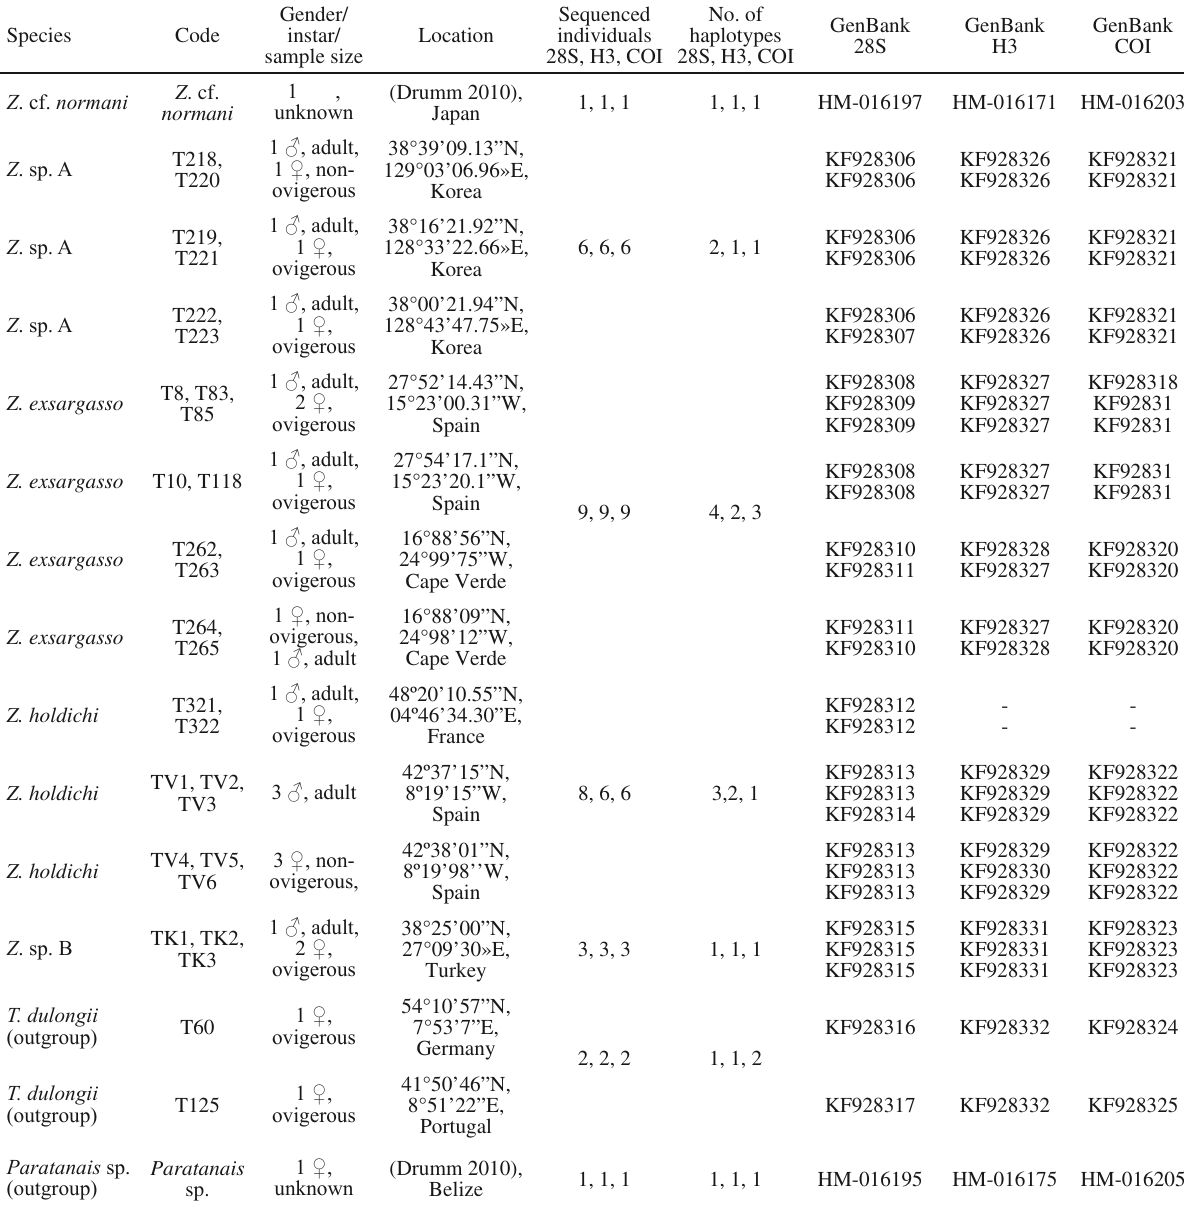
Table 1. – Details of Zeuxo material: collection locations, numbers of haplotypes, and gene sequences used in the present study